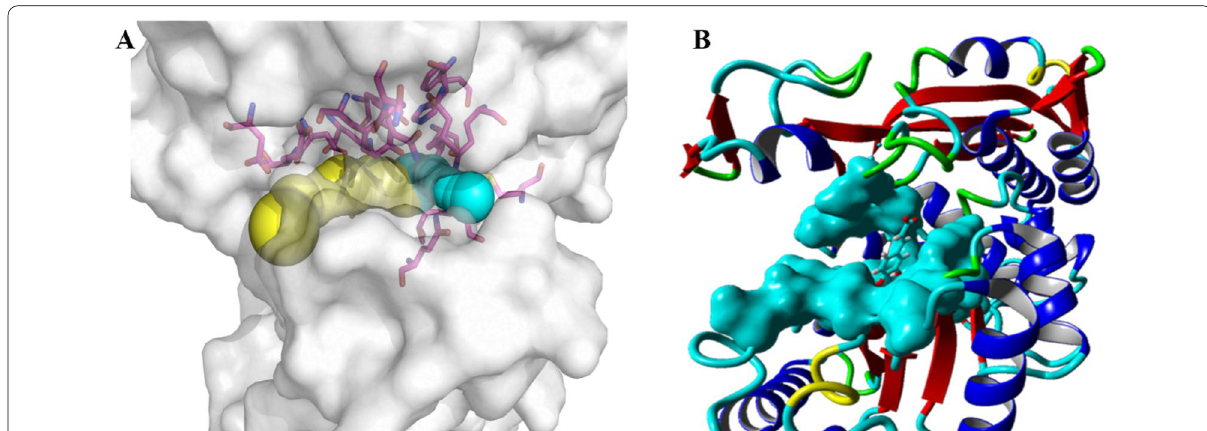
Fig. 2 Spatial structure information of substrate–enzyme docking. A The position relationship between Ec MAL channels and the active sites. The target residues of libraries A–E are displayed in purple sticks. The substrate tunnel is shown in yellow and blue. B Poses of caffeic acid docked in the modeled structure of Ec MAL. The substrate caffeic acid is shown in azure and the selected residues envelop the substrate in a surface view. The visualization of Ec MAL channel, substrate and target amino acid residues was achieved by Pymol and Yasara